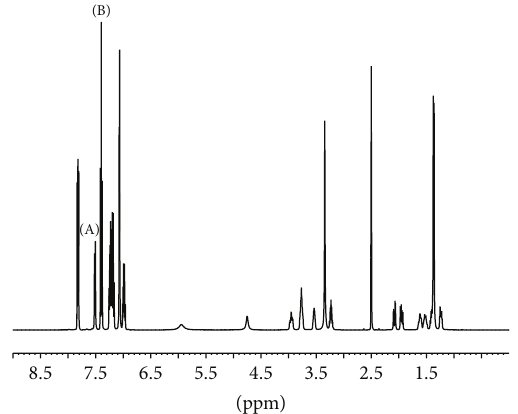
Figure 2: 1 H qNMR spectrum of atorvastatin calcium (A) and internal standard (B).